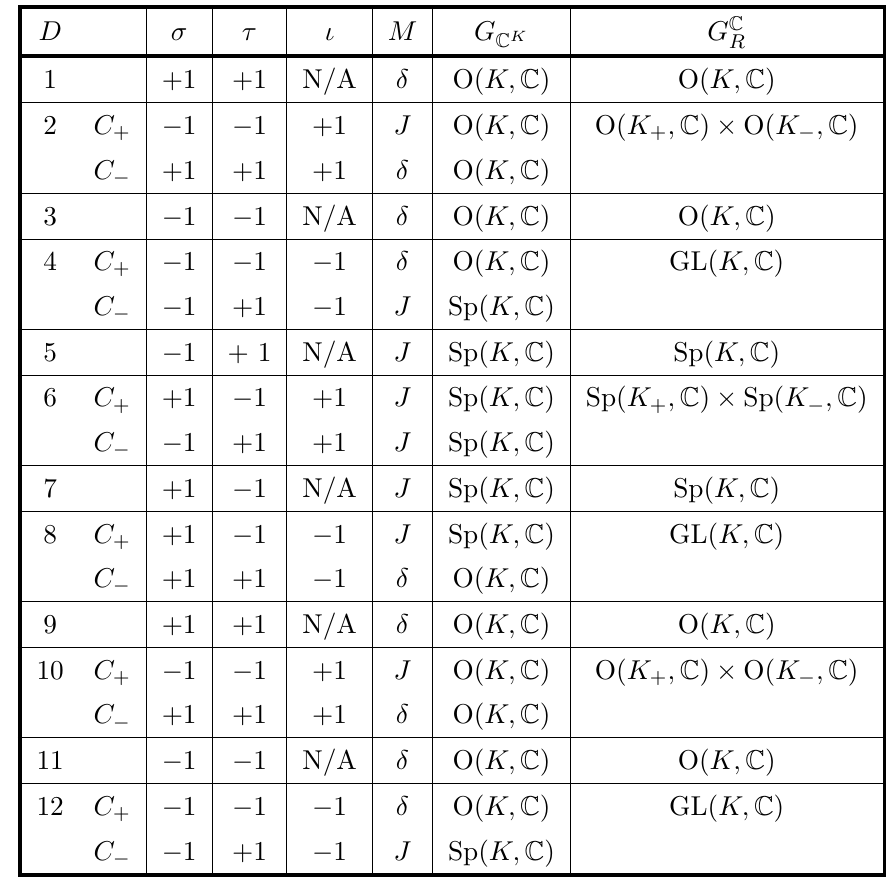
Table 2. This table provides a list of complex supersymmetry algebras. For each dimension we list the inequivalent Majorana bilinear forms (charge conjugation matrices) C together with their invariants σ (symmetry), τ (type), and, where applicable ι (isotropy). For each C we list the corresponding choice of a bilinear form M on the internal space C K which makes β = C ⊗ M super-admissible, thus defining a complex supersymmetry algebra. G and G C the resulting complex R-symmetry group. The pattern in this table repeats modulo 8, and R since C and C define isomorphic superbrackets, complex supersymmetry algebras are + −